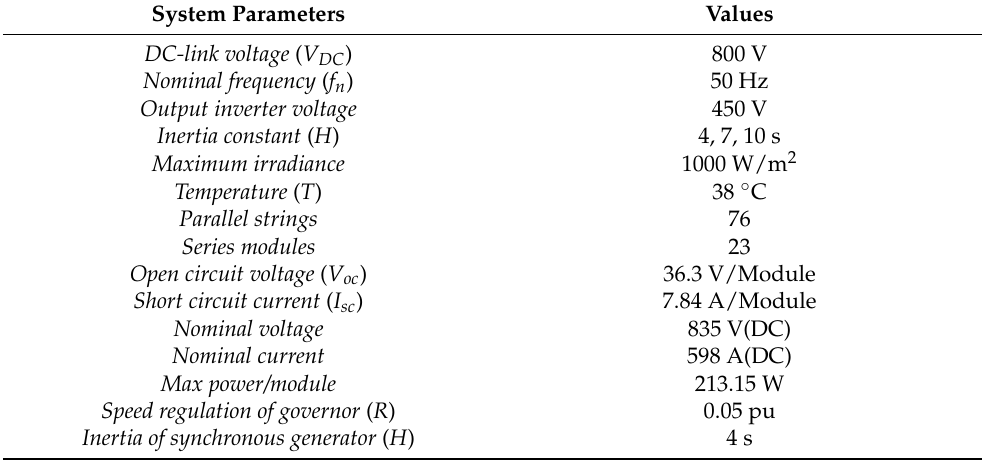
Table 2. Test system